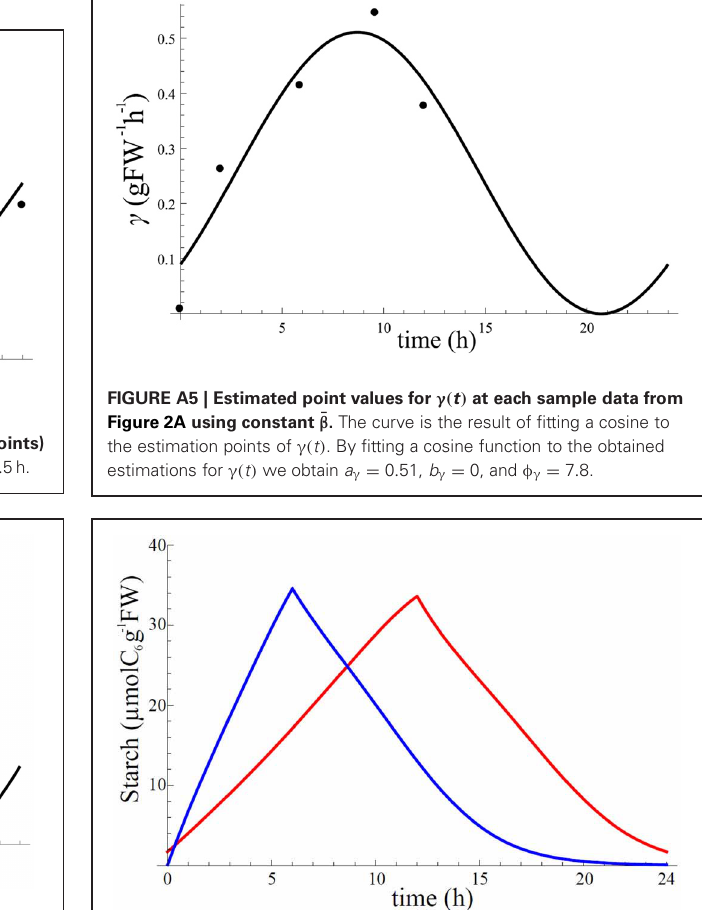
FIGURE A6 | Starch profile for model 8 after convergence of gradient descent using homeostasis cost function. Red is for 12 h/12h and blue is for 6h/18h L/D